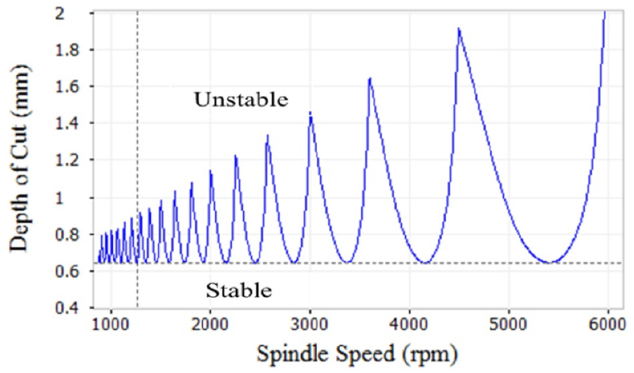
Figure 4. Analytical stability lobe diagram of the hard milling test.